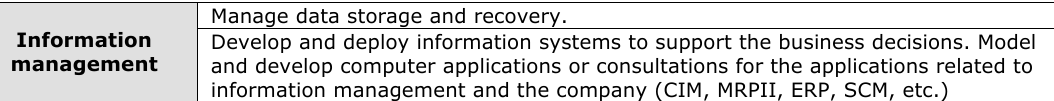
Table 2b. “Specific competences of Industrial